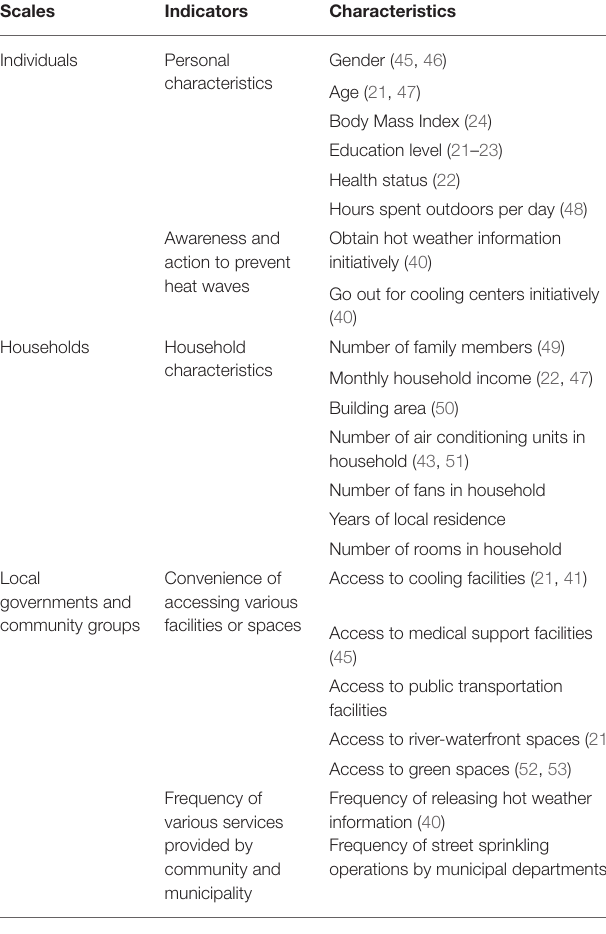
TABLE 1 | Characteristics associated with residents’ HAC.